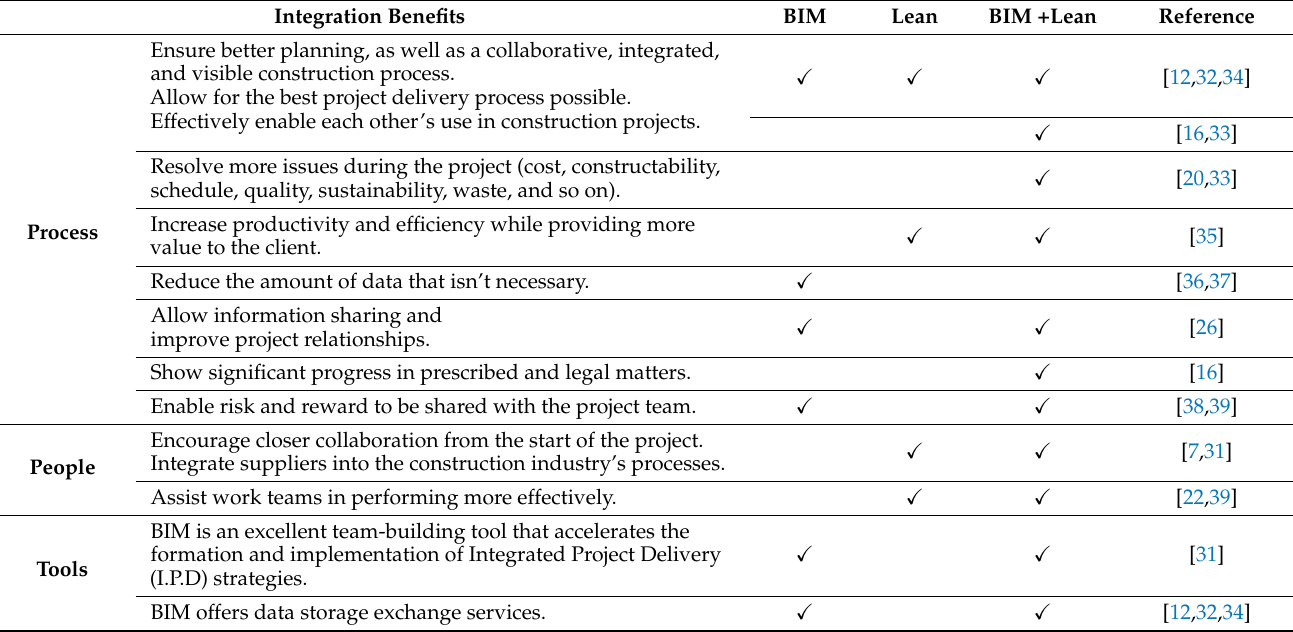
Table 1. Benefits of integrating Lean, and BIM in construction management practice. Integration Benefits BIM Lean BIM +Lean Reference